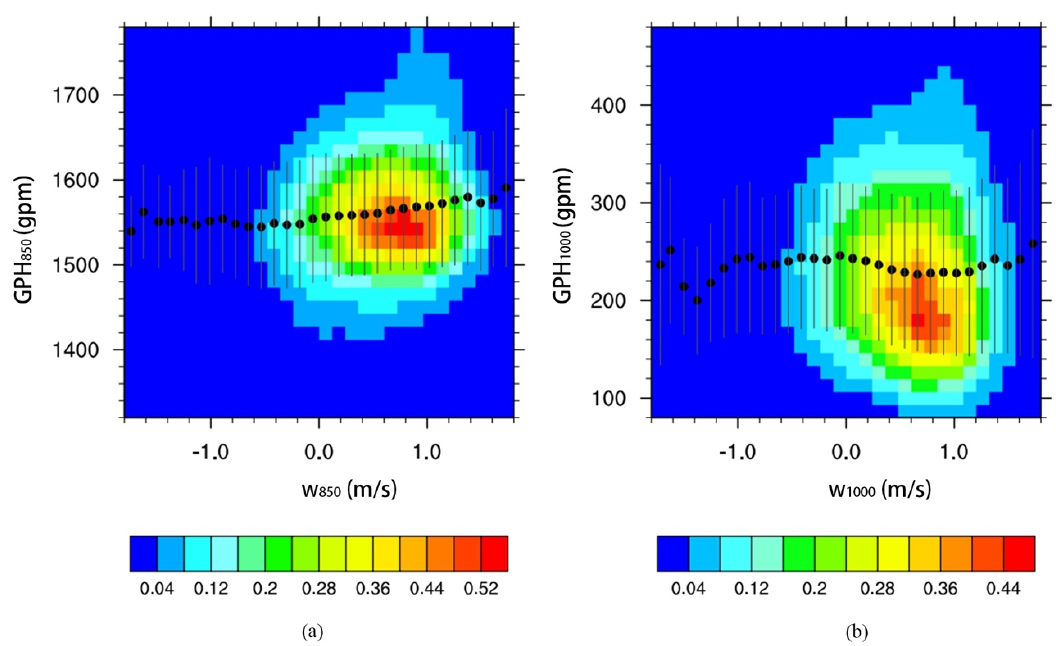
Figure 11. The joint probability density distribution of ( a ) GPH 850 and w 850 and ( b ) GPH 1000 and w 1000 for mid − and low − level clouds (CR4, CR5, CR6, and CR7) in western China. The dots lines are the relationships between GPH and w. The vertical bars represent ± one standard error.